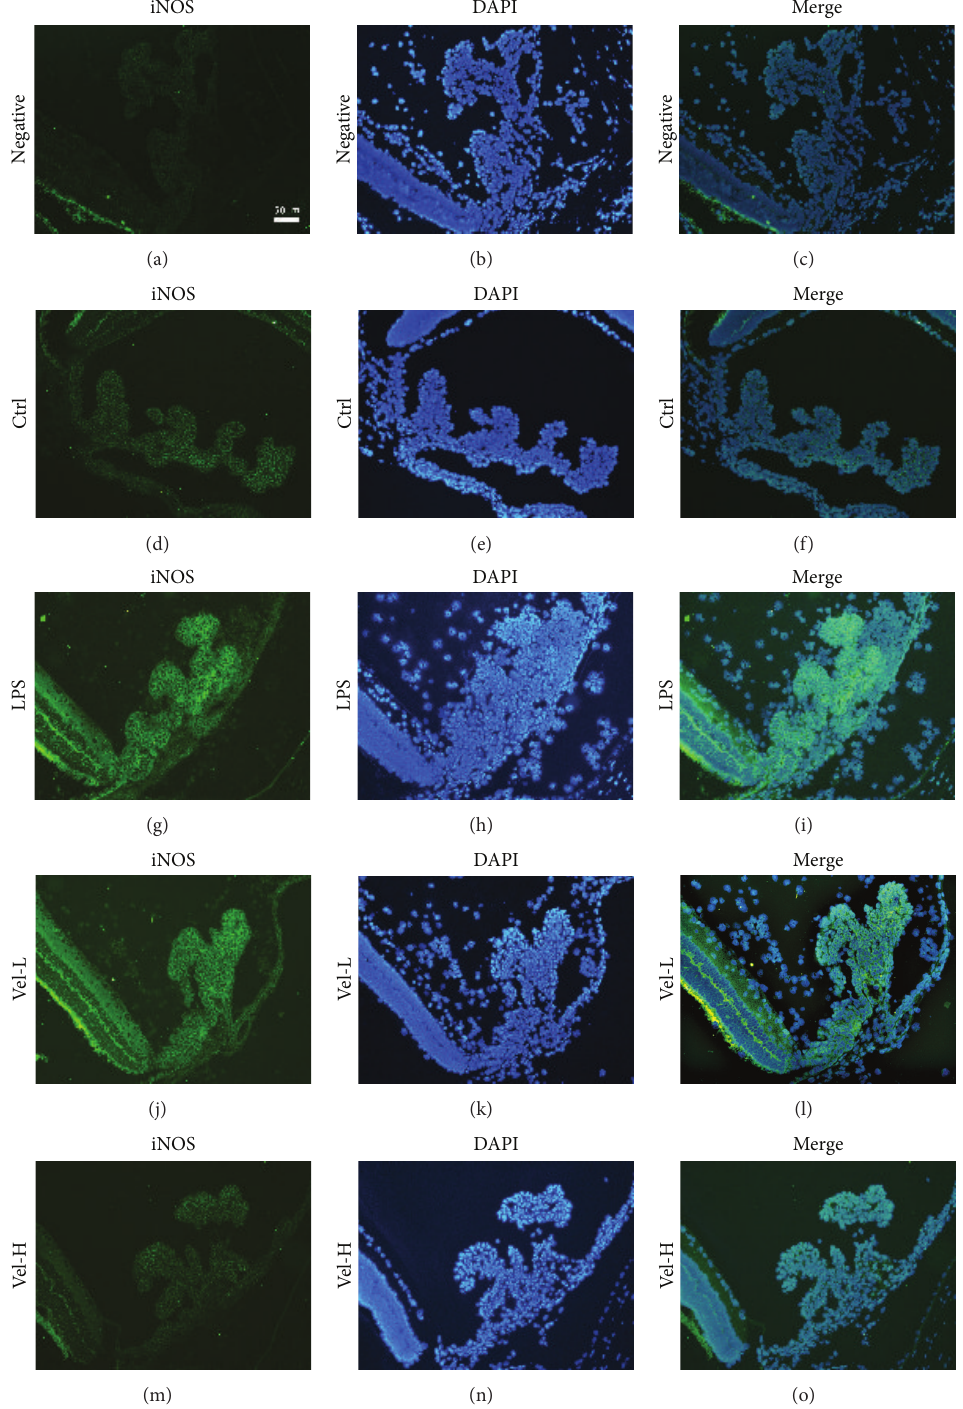
Figure 3: Expression of iNOS in the iris and ciliary bodies detected by immunofluorescence staining. Vel-L = low-dose bortezomib; Vel-H = high-dose bortezomib; iNOS was expressed in green, while the counterstain DAPI (4 󸀠 ,6-diamidino-2-phenylindole) was expressed in blue. iNOS was only expressed in the LPS- (g) and low-dose bortezomib-treated (j) groups. Treatment with high-dose bortezomib (m) reduced the iNOS expression in the ciliary bodies of EIU rats. Scale bar = 50 𝜇